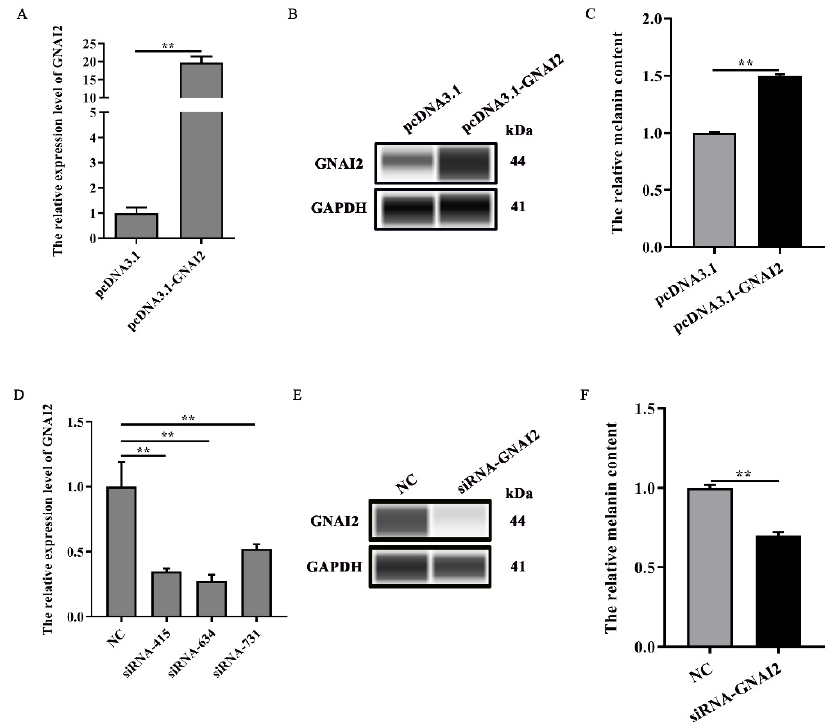
Figure 3. GNAI2 promoted melanogenesis: ( A ) GNAI2 mRNA expression levels in GNAI2-overexpressing melanocytes were detected using a qRT-PCR assay; ( B ) the GNAI2 protein expression was determined using Wes assay after GNAI2 was overexpressed in melanocytes; ( C ) the melanin content was measured in GNAI2-overexpressing melanocytes using NaOH lysates; ( D ) GNAI2 mRNA expression levels were determined in GNAI2-silenced melanocytes using a qRT-PCR; ( E ) the GNAI2 protein levels were determined using Wes assay after GNAI2 was knocked down in melanocytes; ( F ) the melanin content was measured in GNAI2-silenced melanocytes using NaOH lysates. **, p < 0.01.